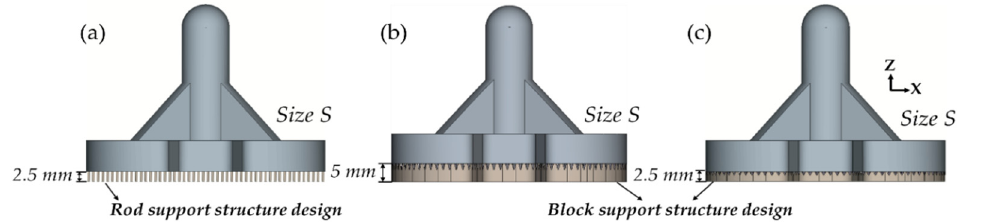
Figure 4. The model of tibial component with small size (S) on the different support -structure designs and support heights. ( a ) Rod support-structure design with height of 5 mm; ( b ) Block support-structure design with height of 5 mm; ( c ) Block support-structure design with height of 2.5 mm. Figure 5 illustrates the patterns and dimensions of the support structure. The support volume for support-structure design with height of 5 mm case and height of 2.5 mm case were 1560 mm 3 and 780 mm 3 respectively.